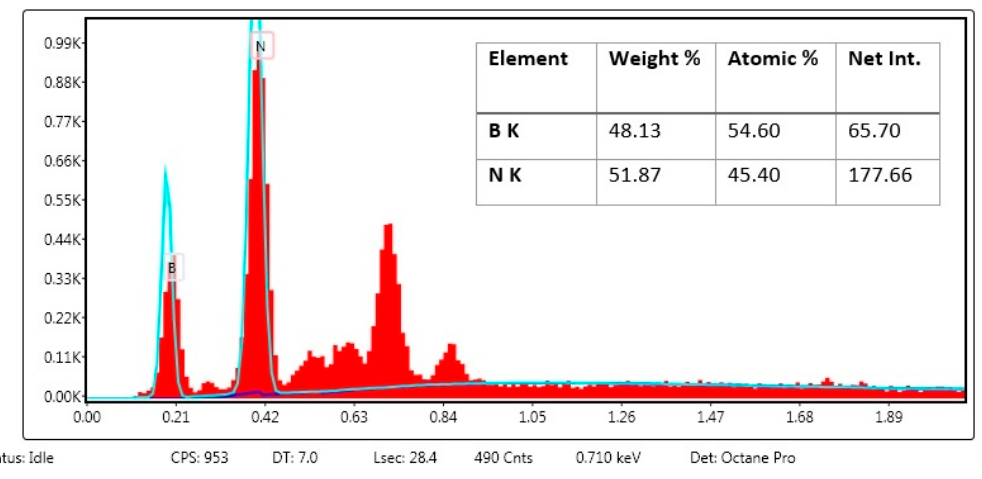
Figure 2. EDX analysis of hBN nanoparticles.